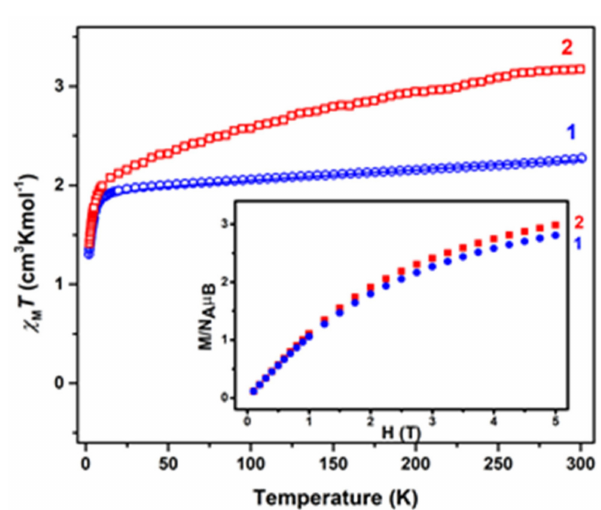
Figure 3. Plots of χ M T vs. T at 1000 Oe and M vs. H at 2 K (inset) for 1 ( blue ) and 2 ( red ). Solid line for 1 represents the best fit obtained with the magnetic model described in the